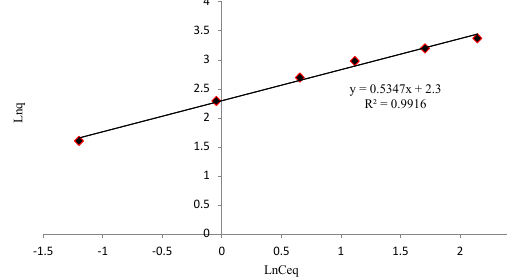
Fig. 11. Freundlich isotherm plot for adsorption of Hg (II) onto Fig.11:FreundlichisothermplotforadsorptionofHg(II)ontoFe 3 O 4 -Polyrhodanineat25 ◦ C Fe3O4-Polyrhodanine at 25 ◦C